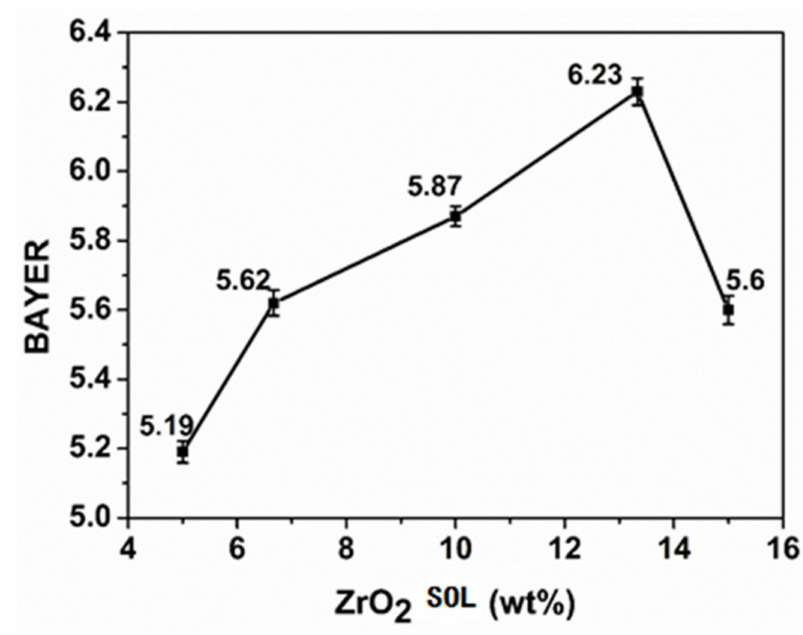
Figure 9. Variation of Bayer ratio of composite coatings with di ff erent ZrO 2 sol content.